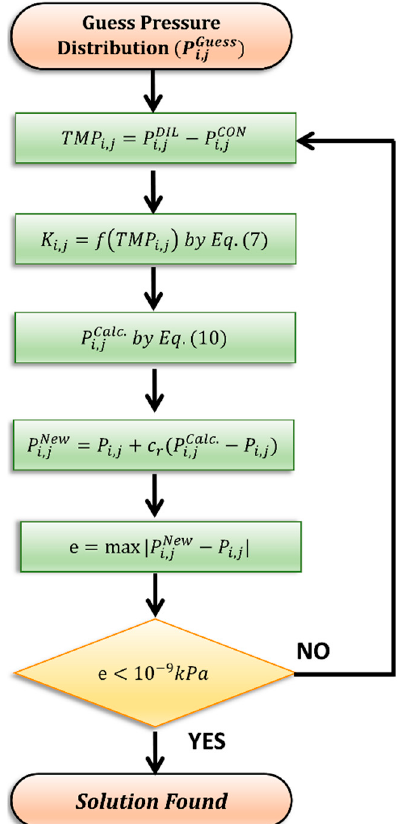
Figure 5. Flowchart of the iterative algorithm for the case of low velocity.